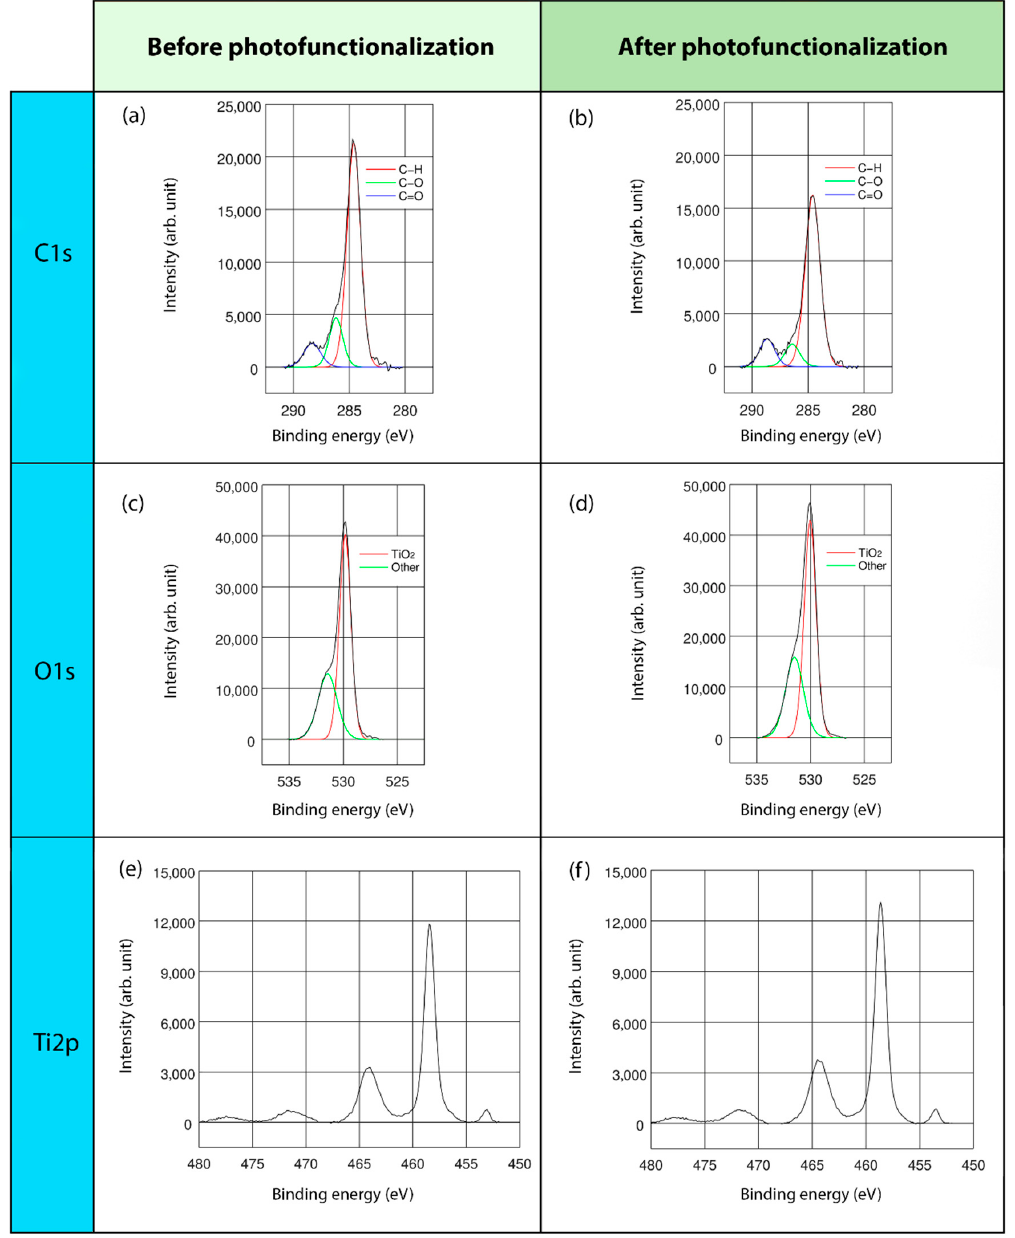
Figure 2. XPS analyses of THD surface: XPS full-range spectra and deconvoluted XPS, with lines analysis and binding energies of C1s, O1s, and Ti2p; before ( a , c , e ) and after ( b , d , f ) LED-based UVC photofunctionalization.